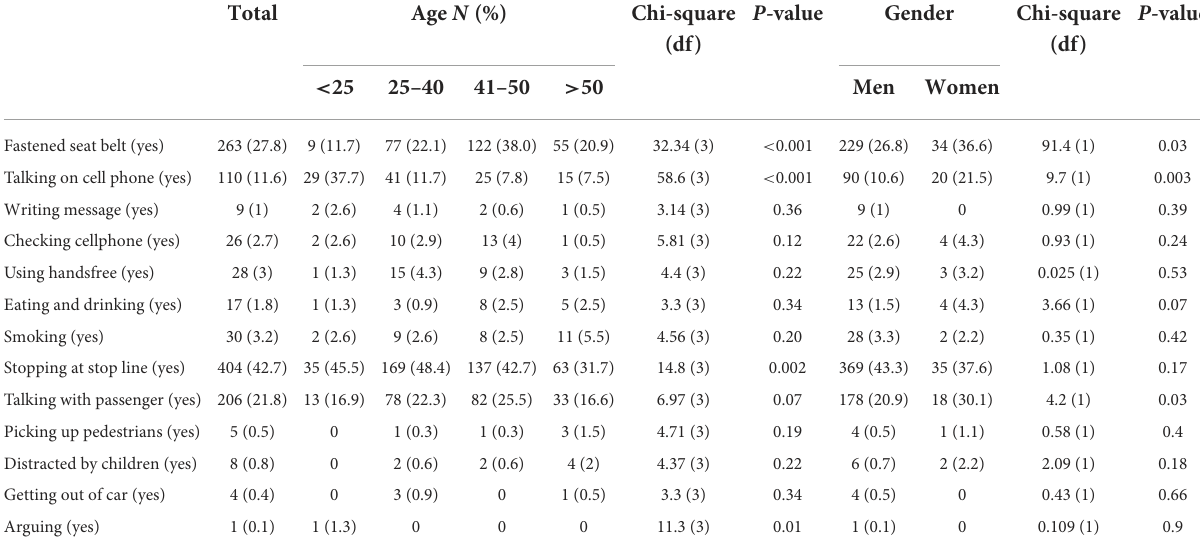
TABLE 2 Behaviors of drivers at traffic lights based on age and gender (N =